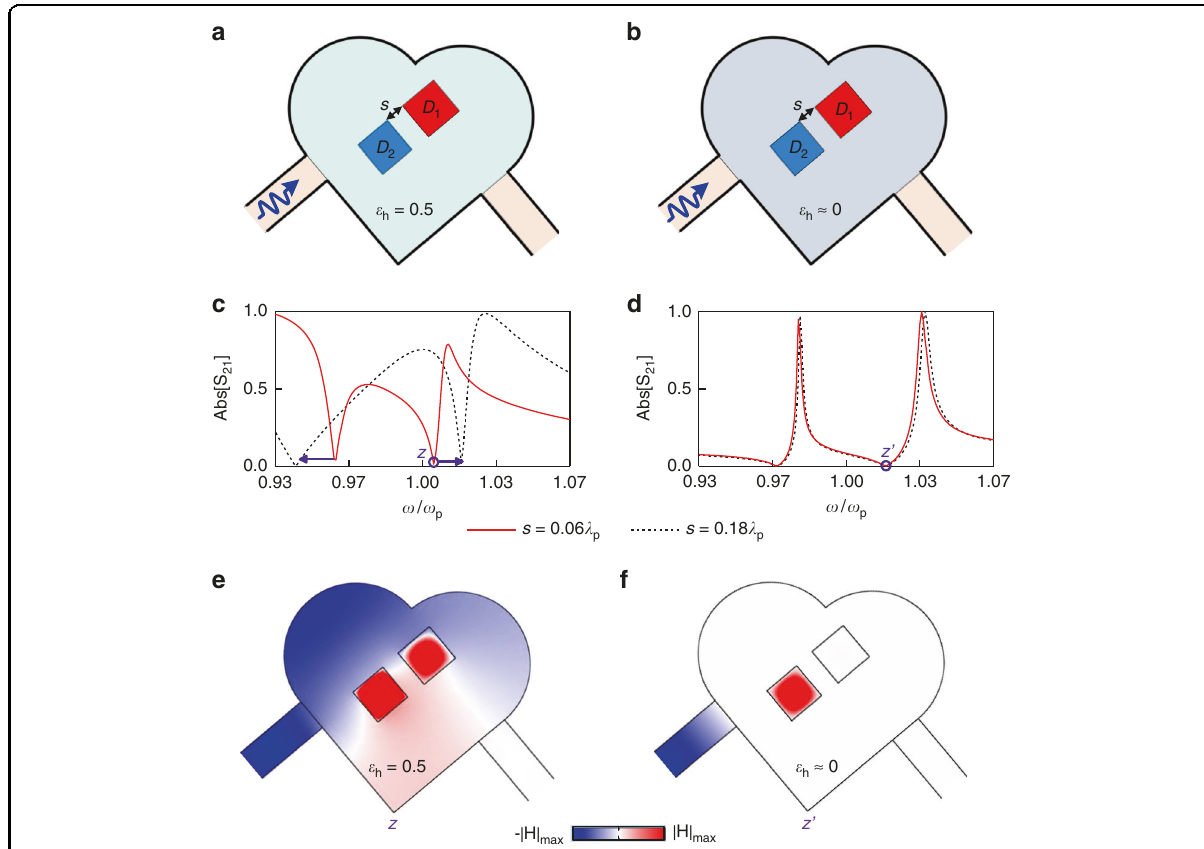
Fig. 2 Properties of multiple dielectric rods in the ENZ and non-ENZ hosts. Con fi gurations of ( a) the two-dimensional (2D) non-ENZ host ( ε h = 0.5) and ( b ) ENZ host ( ε h ≈ 0) containing two square dielectric rods. The permittivity of ENZ medium is Drude dispersive, with the angular plasma frequency of ω p = 2 π × 3 × 10 9 rad/s. Host areas in two cases are 0.33 λ p2 ( λ p is the free-space wavelength at ω p ), while square rods D 1 and D 2 are chosen with the permittivity ε d = 37 and side lengths of 0.122 λ p and 0.116 λ p , respectively. ( c ) and ( d ) are respectively the simulated transmission spectral response in non-ENZ and ENZ hosts, for different spacing s of dielectric rods. ( e ) and ( f ) are snapshots of the magnetic fi eld distribution at